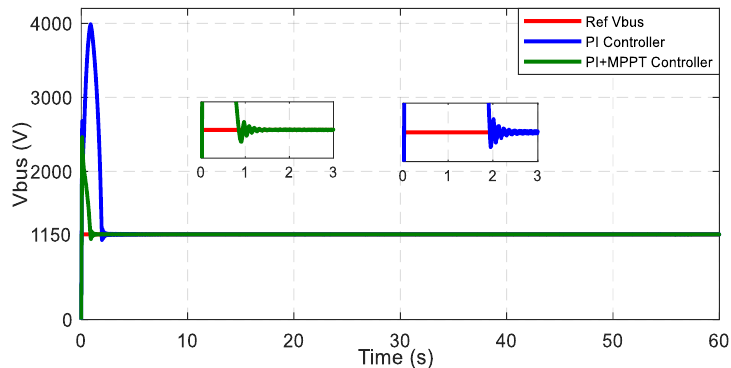
Figure 14. DC bus voltages of WECS.